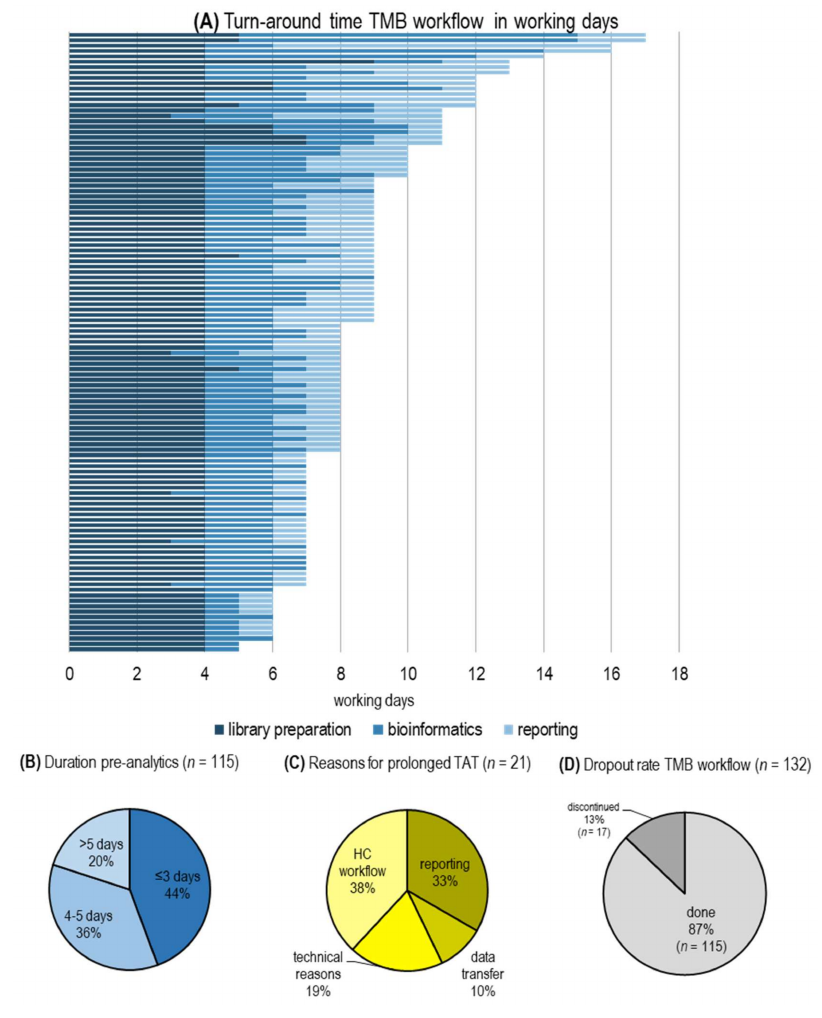
Figure 2. Turn-around time for TMB evaluation. ( A ) TAT in working days per case from start of HC NGS workflow to reporting; ( B ) Duration of pre-analytics including tissue embedding and DNA extraction; ( C ) Reasons for prolonged TAT ( > 10 working days); ( D ) Percentage of cases not meeting quality